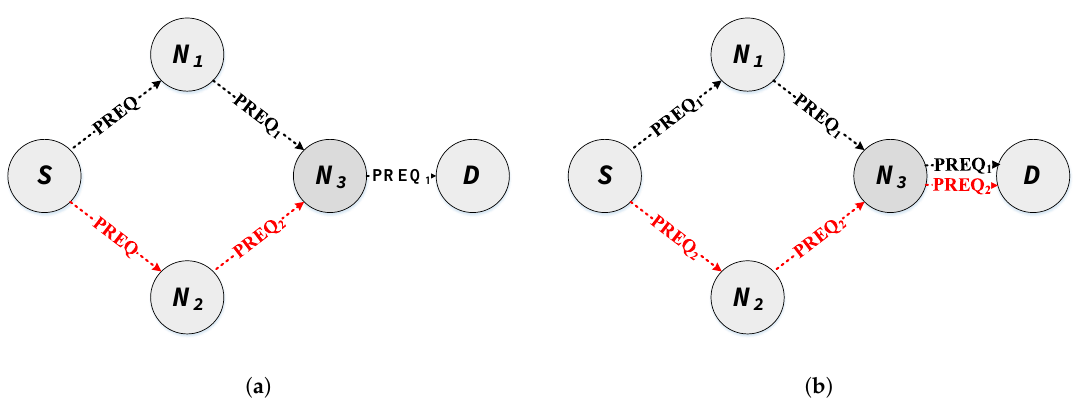
Figure 2. Modification to the acceptance criteria when the intermediary nodes receive a PREQ message.